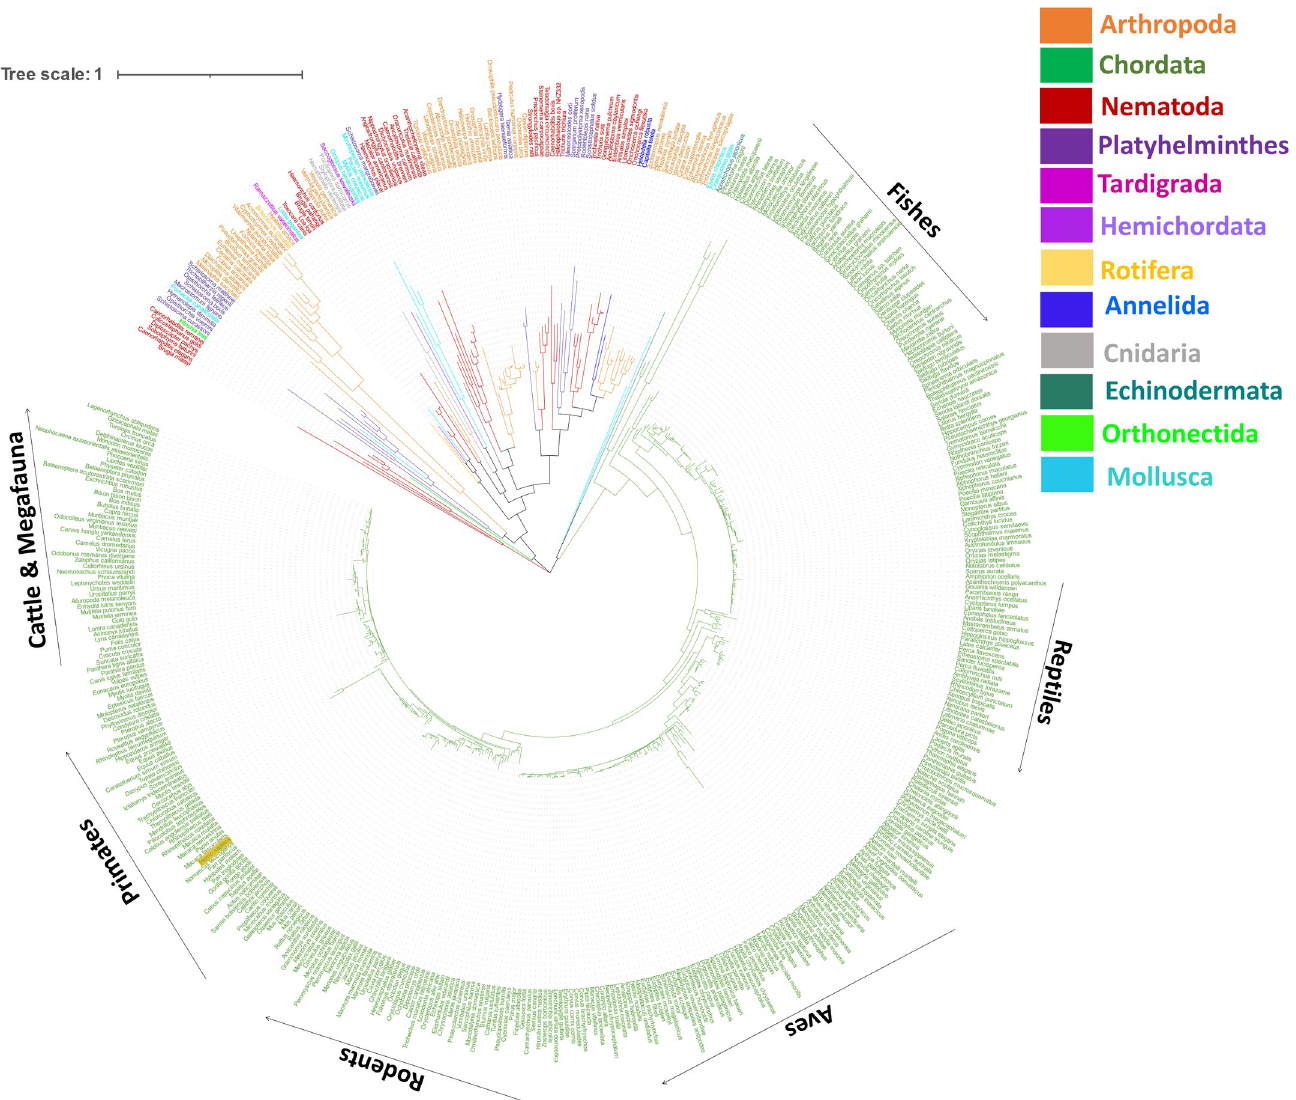
Fig 2. Phylogenetic tree of 5HT3A homolog proteins from animal phyla. The colours of the species in the tree correspond to the colours of the phyla in the figure legend: Chordata (green with the human sequence highlighted with amber background), Nematoda (dark red), Arthropoda (orange), Platyhelminthes (dark purple), Mollusca (cyan), Rotifera (yellow), Tardigrada (maroon), Hemichordata (purple), Orthonectida (pale green), Echinodermata (teal), Annelida (blue) and Cnidaria (grey). This analysis involved 494 amino acid sequences. There was a total of 292 alignment positions in the final dataset. Evolutionary analyses were conducted in MEGA X and tree editing was performed in iTOL. Tree scale represents the number of differences between sequences.